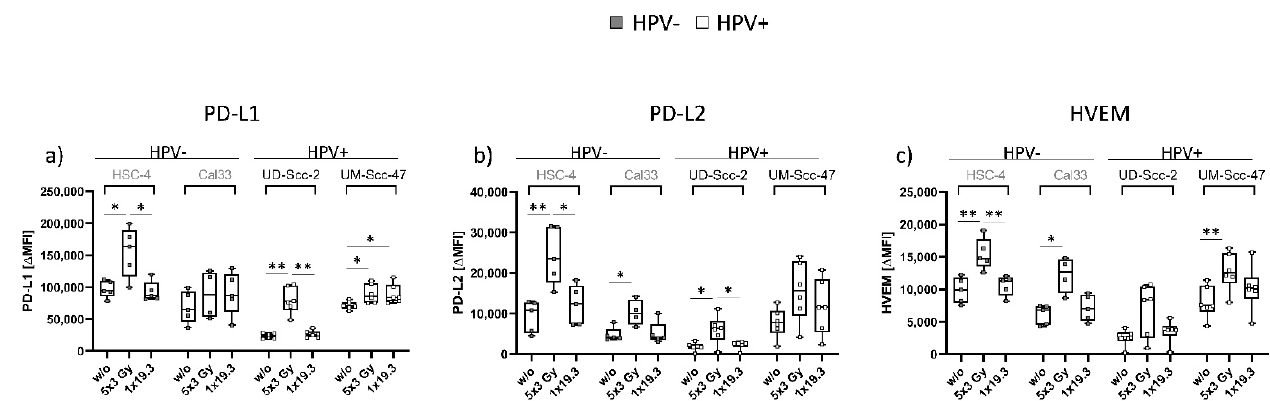
Figure 2. Cell surface expression of immune suppressive checkpoint molecules PD-L1 ( a ), PD-L2 ( b ), and HVEM ( c ) on the cell surface of HPV-negative (grey dots) and HPV-positive (white dots) HNSCC cell lines with n hpv − = 5; n hpv+ = 6 biological independent experiments. Cells were subjected to either a hypofractionated irradiation regimen (5x3.0Gy) or a single high dose of 19.3Gy. Δ MFI was calculated by subtracting the respective stained samples from Zombie-only-treated samples. Graphs show median + min to max, and a two-sided Mann–Whitney U test was performed for comparisons of treatments within one cell line: * p < 0.05, ** p < 0.01.